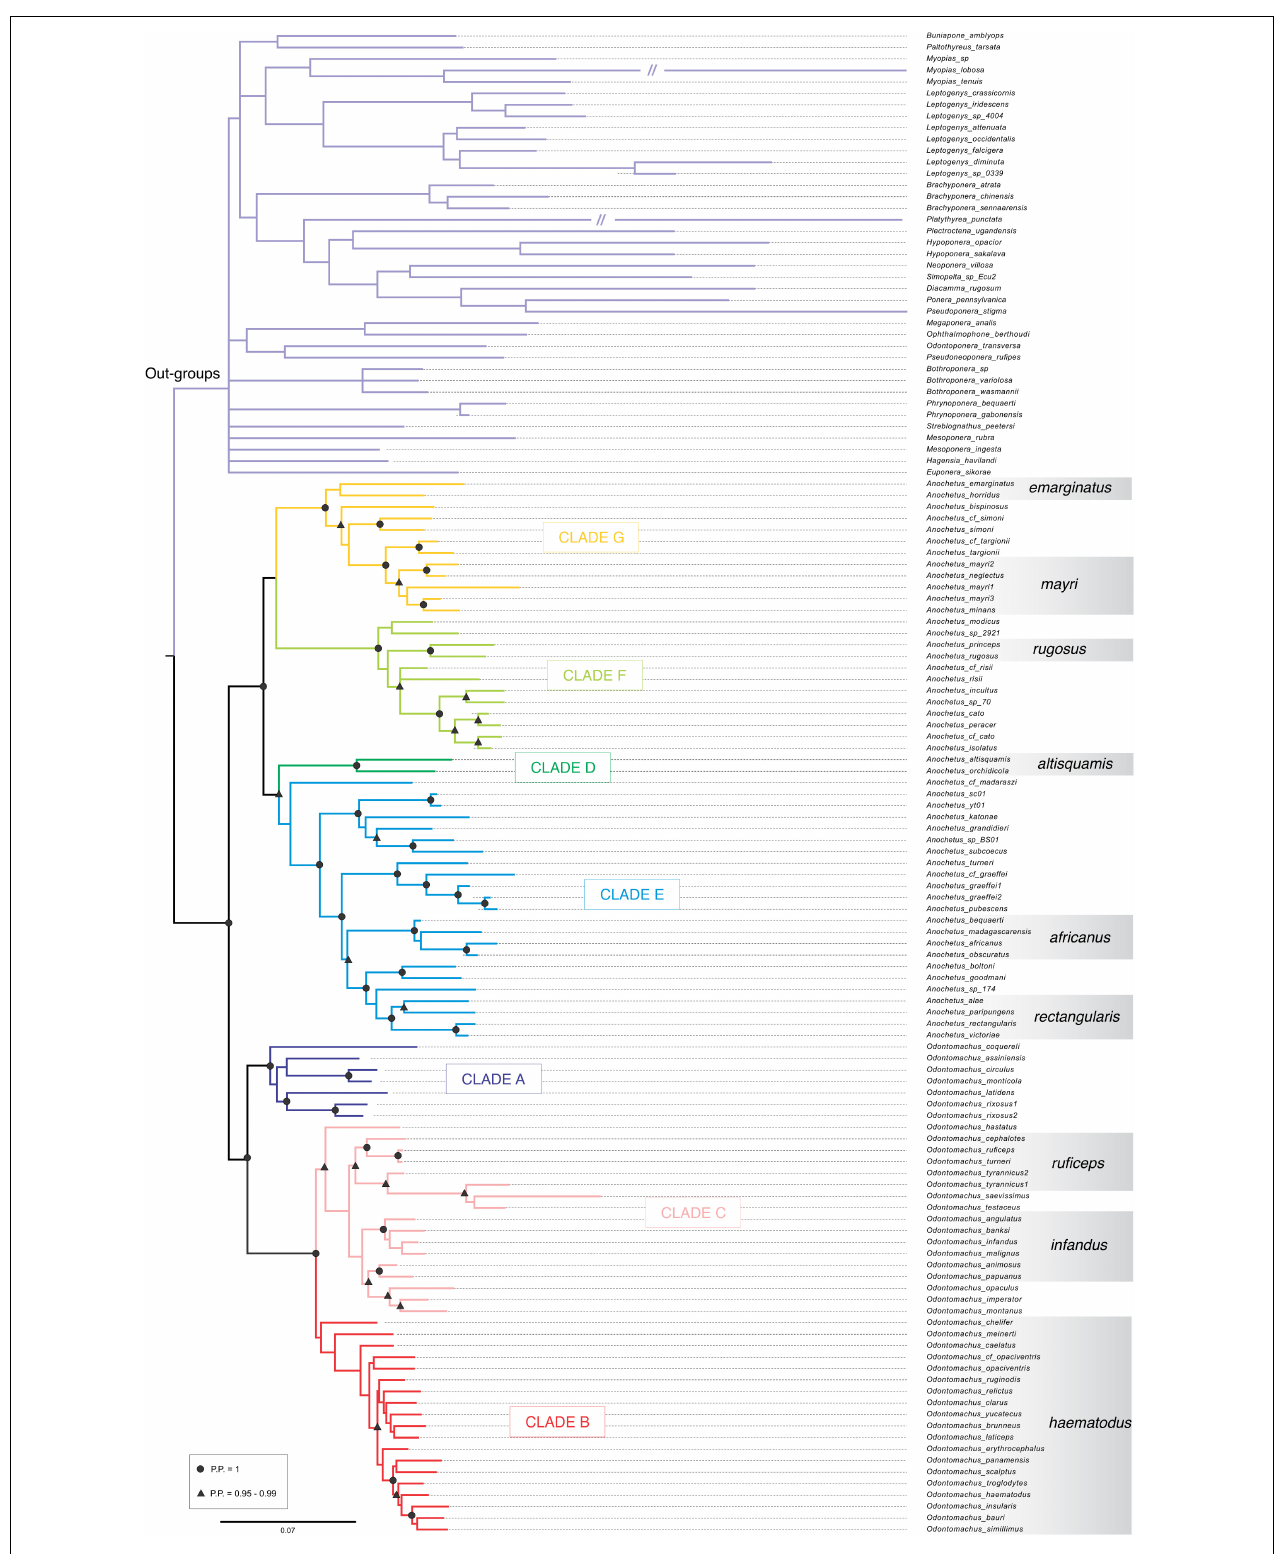
FIGURE 1 | Global molecular phylogeny of trap-jaw ants reconstructed under Bayesian inference used to ancestral chromosome reconstruction. Clades A–G are highlighted in different colors. Morphological groups proposed by Brown (1978), are shown at the right side of the tree. The outgroup can be found at the top of the figure in light